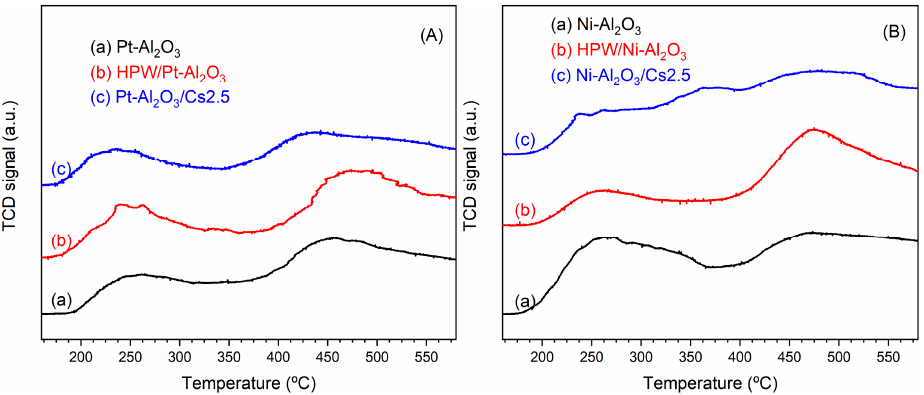
Figure 9. NH 3 -TPD profiles of the different catalysts: ( A ) Pt-Al 2 O 3 series; ( B ) Ni-Al 2 O 3 series.